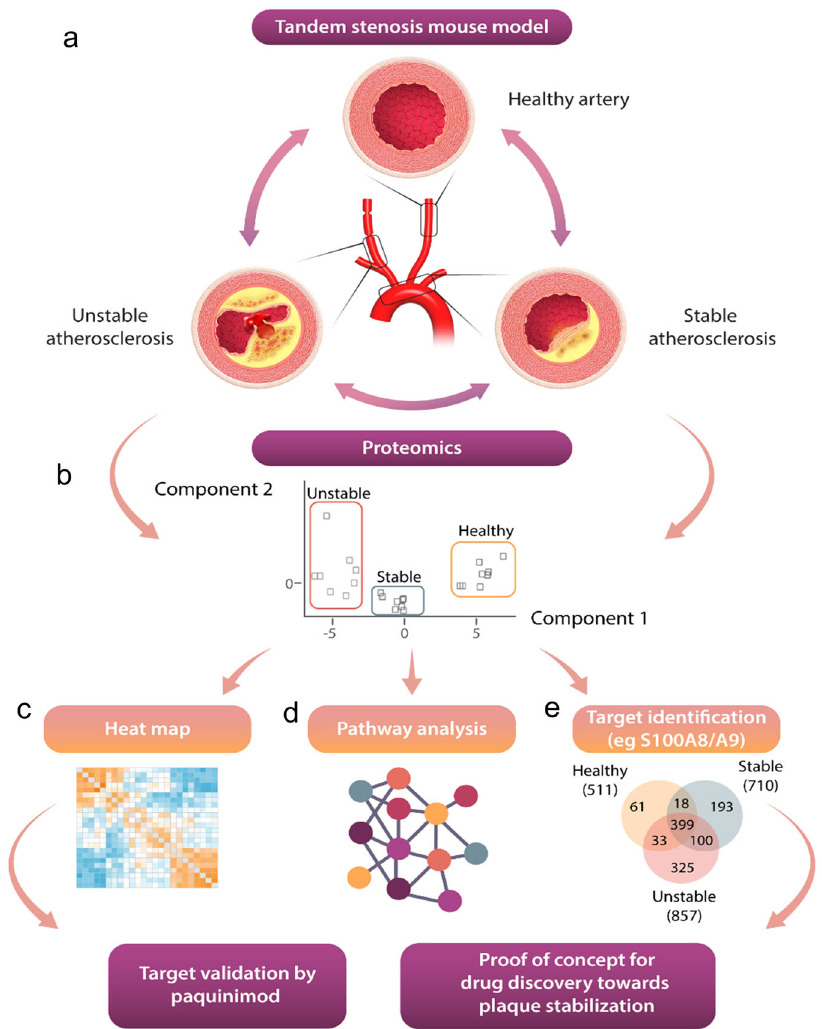
Fig. 1 Work fl ow of quantitative proteomic comparison of unstable and stable atherosclerosis as well as healthy vessels using the tandem stenosis (TS) mouse model. a Schematic work fl ow of proteomic analyses of vascular segments representing unstable, stable atherosclerosis (aortic arch, red), and healthy artery. Each segment ( n = 15) was isolated and pooled for protein extraction, gel electrophoresis, and in-gel tryptic digestion. Single-shot label-free quantitative mass spectrometry was performed. The schematic drawing was created by somersault18:24 BV. b Principal component analysis and sample correlation matrix of distinct tissue groups (healthy arteries, stable plaques, unstable plaques). ( c / d / e ) Heat map, pathway/network enrichment analysis of unstable and stable plaque proteomes, and distributions of proteins identi fi ed across plaque compositions. Molecular target identi fi cation for plaque stabilization and validation in human plaques and the TS